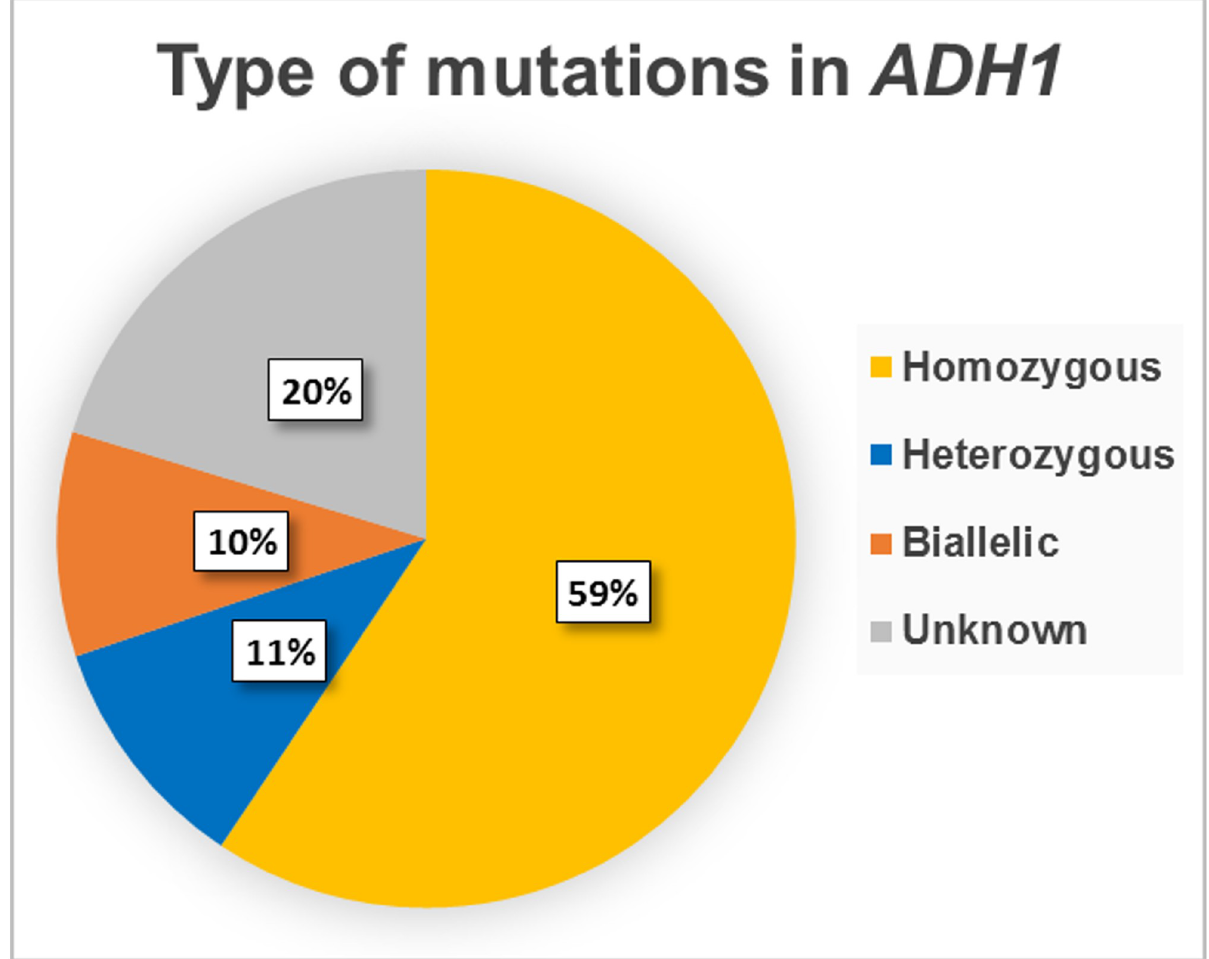
Fig 9. Genotype at ADH1 locus confirmed by capillary sequencing. For each T2 family tested, up to six allyl-alcohol resistant plants were genotyped by capillary sequencing of an sgRNA target ( ADH1 ) PCR amplicon. We retrieved a total of 315 sequences with a mutation. 59% (187) showed a single sequencing signal, different than ADH1 WT and were classified as “Homozygous”. 11% (33) showed an overlap of two sequencing signals, one matching ADH1 WT and one different; and were classified as “Heterozygous”. 10% (31) showed an overlap of two sequencing signals, none matching ADH1 WT; and were classified as “Biallelic”. 64 (20%) showed an overlap of signals different than WT but not clear enough to distinguish; and were classified as “Unknown”. The “Unknown” sequences can be biallelic or due to somatic mutations but are different than WT, heterozygous or homozygous